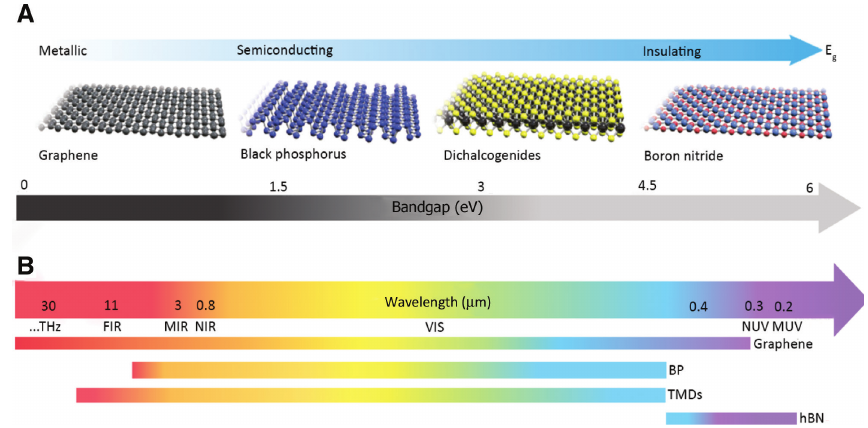
Figure 1: Bandgap of 2D materials and their corresponding operation wavelength. (A) A broad library of two-dimensional layered materials (2DLMs) with varying chemical composition, atomic structures, and electronic properties, with an increasing bandgap from left to right. (B) Radiation wavelength from terahertz to ultraviolet. The 2D material-based applications cover a wide range of radiation wavelengths from the THz through UV range (A reproduced from [23] with permission from Nature Review